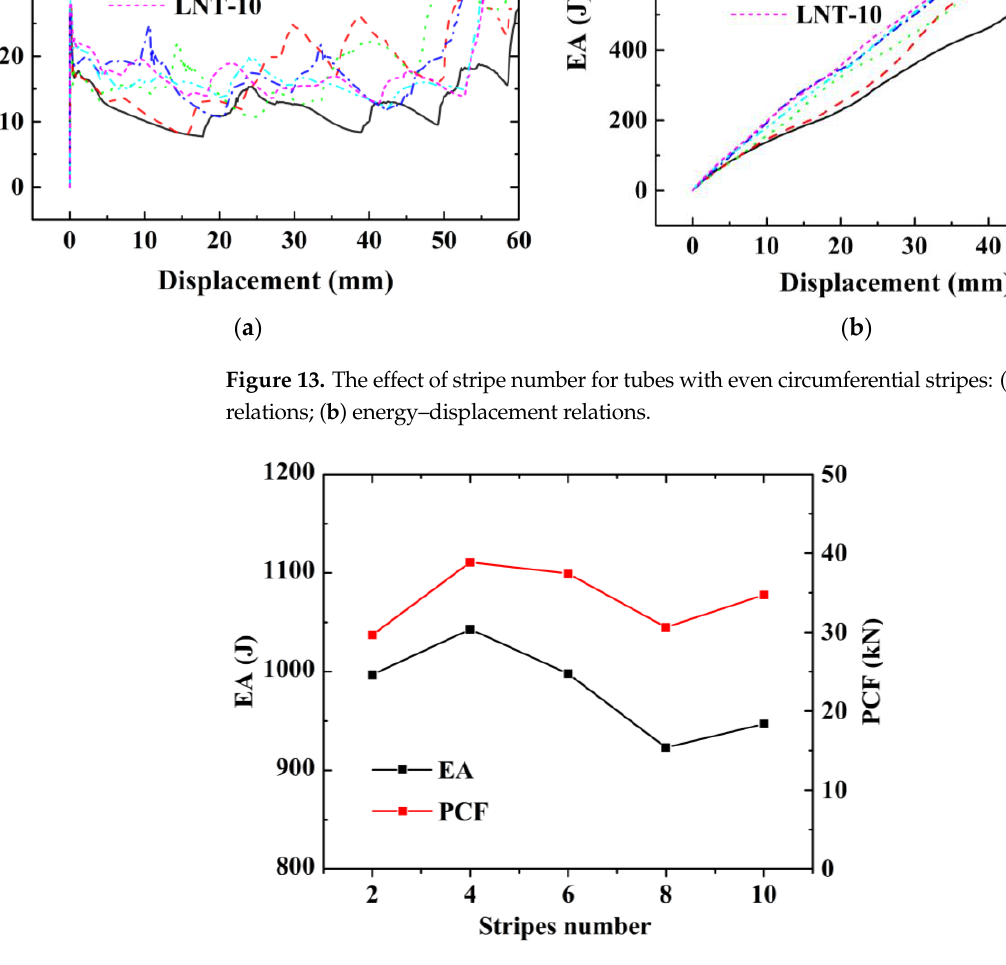
Figure 13. The effect of stripe number for tubes with even circumferential stripes: ( a ) load – displace- ment relations; ( b ) energy – displacement relations. Table 8. Effect of stripes on energy absorption properties.